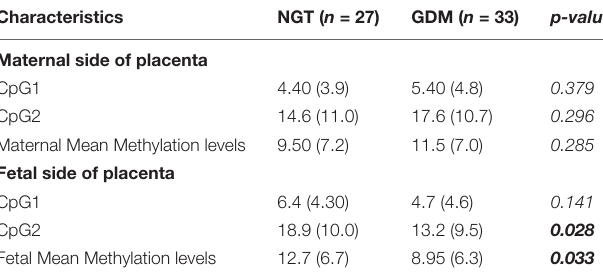
TABLE 3 | MC4R DNA methylation levels on the maternal and fetal side of placenta normoglycemic (NGT) and gestational diabetes (GDM) women expressed as mean and standard deviation (SD). Mean differences were evaluated by unpaired t